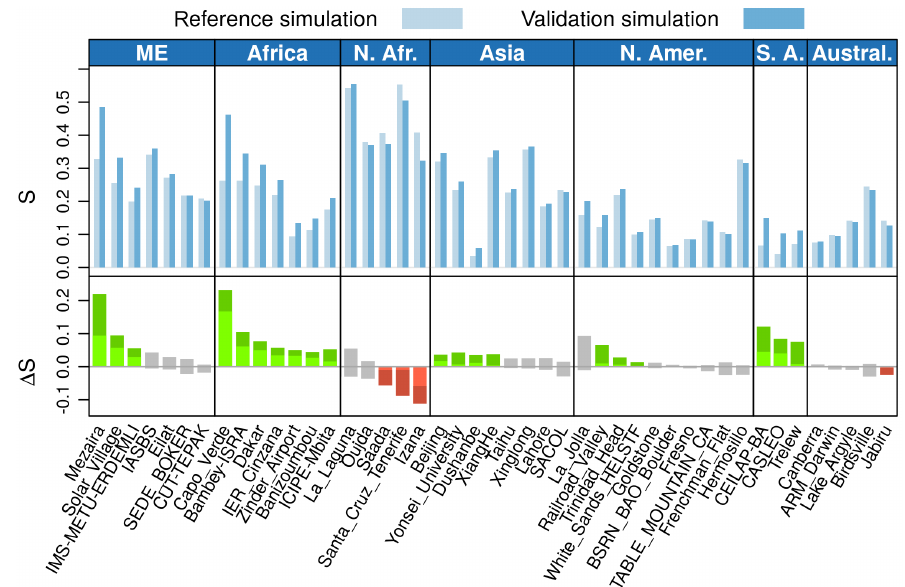
Figure 9. Skill score ( S ) of the daily mean 550nm AOD from reference and validation simulations using AERONET observations as a benchmark. The red, green and grey bars depict the differences between reference and validation values, with green bars indicating that the validation results agree more closely with the measurements by at least 1 standard deviation ( σ ). The corresponding error intervals are indicated by darker colours. Generally, the validation simulation performs better than the reference simulation; regarding the decreased skill scores in north-west Africa, please refer to the discussion in the main